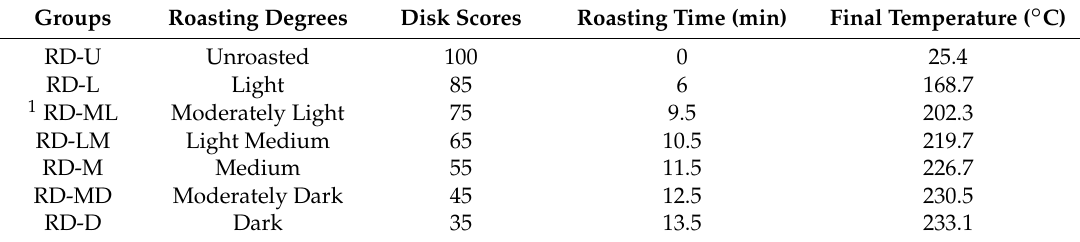
Table 1. Roasting degrees (RDs) for coffee